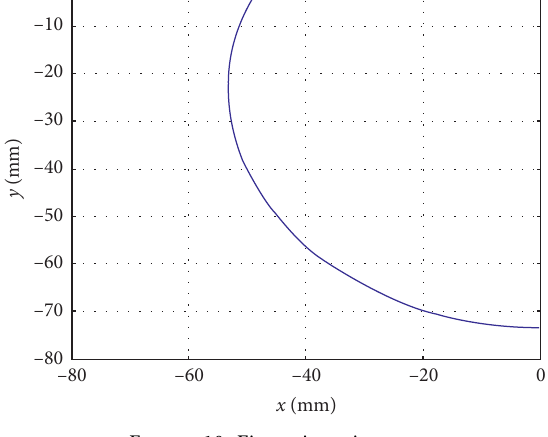
Figure 10: Fingertip trajectory.